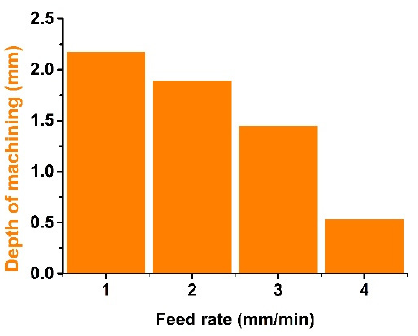
Figure 12. Short-circuit machining depth at different feed rates.